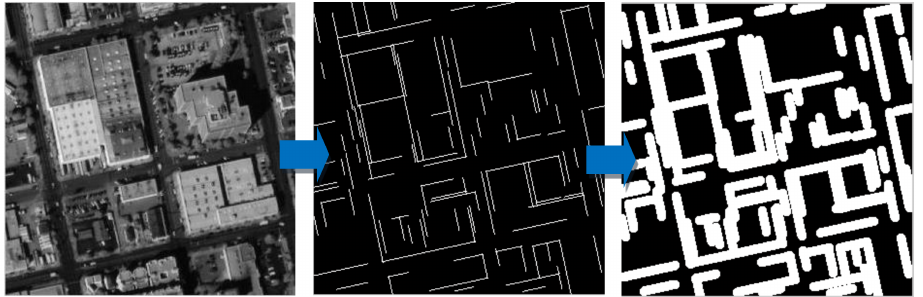
Figure 11. The results of edge line supporting area.